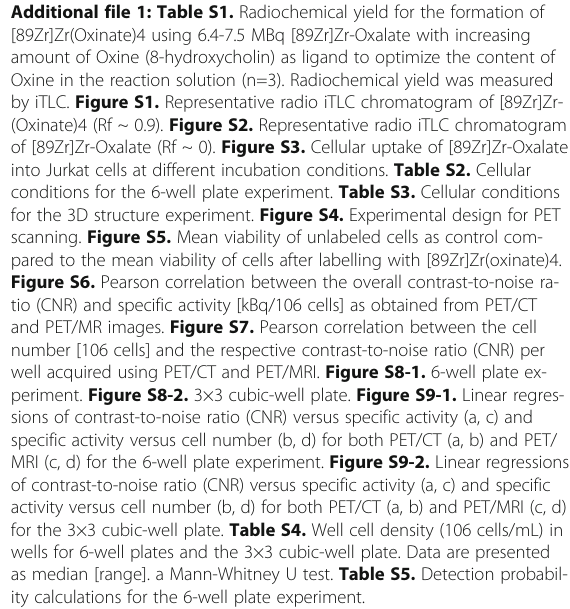
scanning. Figure S5. Mean viability of unlabeled cells as control com- pared to the mean viability of cells after labelling with [89Zr]Zr(oxinate)4. Figure S6. Pearson correlation between the overall contrast-to-noise ra- tio (CNR) and specific activity [kBq/106 cells] as obtained from PET/CT and PET/MR images. Figure S7. Pearson correlation between the cell number [106 cells] and the respective contrast-to-noise ratio (CNR) per well acquired using PET/CT and PET/MRI. Figure S8-1. 6-well plate ex- periment. Figure S8-2. 3×3 cubic-well plate. Figure S9-1. Linear regres- sions of contrast-to-noise ratio (CNR) versus specific activity (a, c) and specific activity versus cell number (b, d) for both PET/CT (a, b) and PET/ MRI (c, d) for the 6-well plate experiment. Figure S9-2. Linear regressions of contrast-to-noise ratio (CNR) versus specific activity (a, c) and specific activity versus cell number (b, d) for both PET/CT (a, b) and PET/MRI (c, d) for the 3×3 cubic-well plate. Table S4. Well cell density (106 cells/mL) in wells for 6-well plates and the 3×3 cubic-well plate. Data are presented as median [range]. a Mann-Whitney U test. Table S5. Detection probabil- ity calculations for the 6-well plate